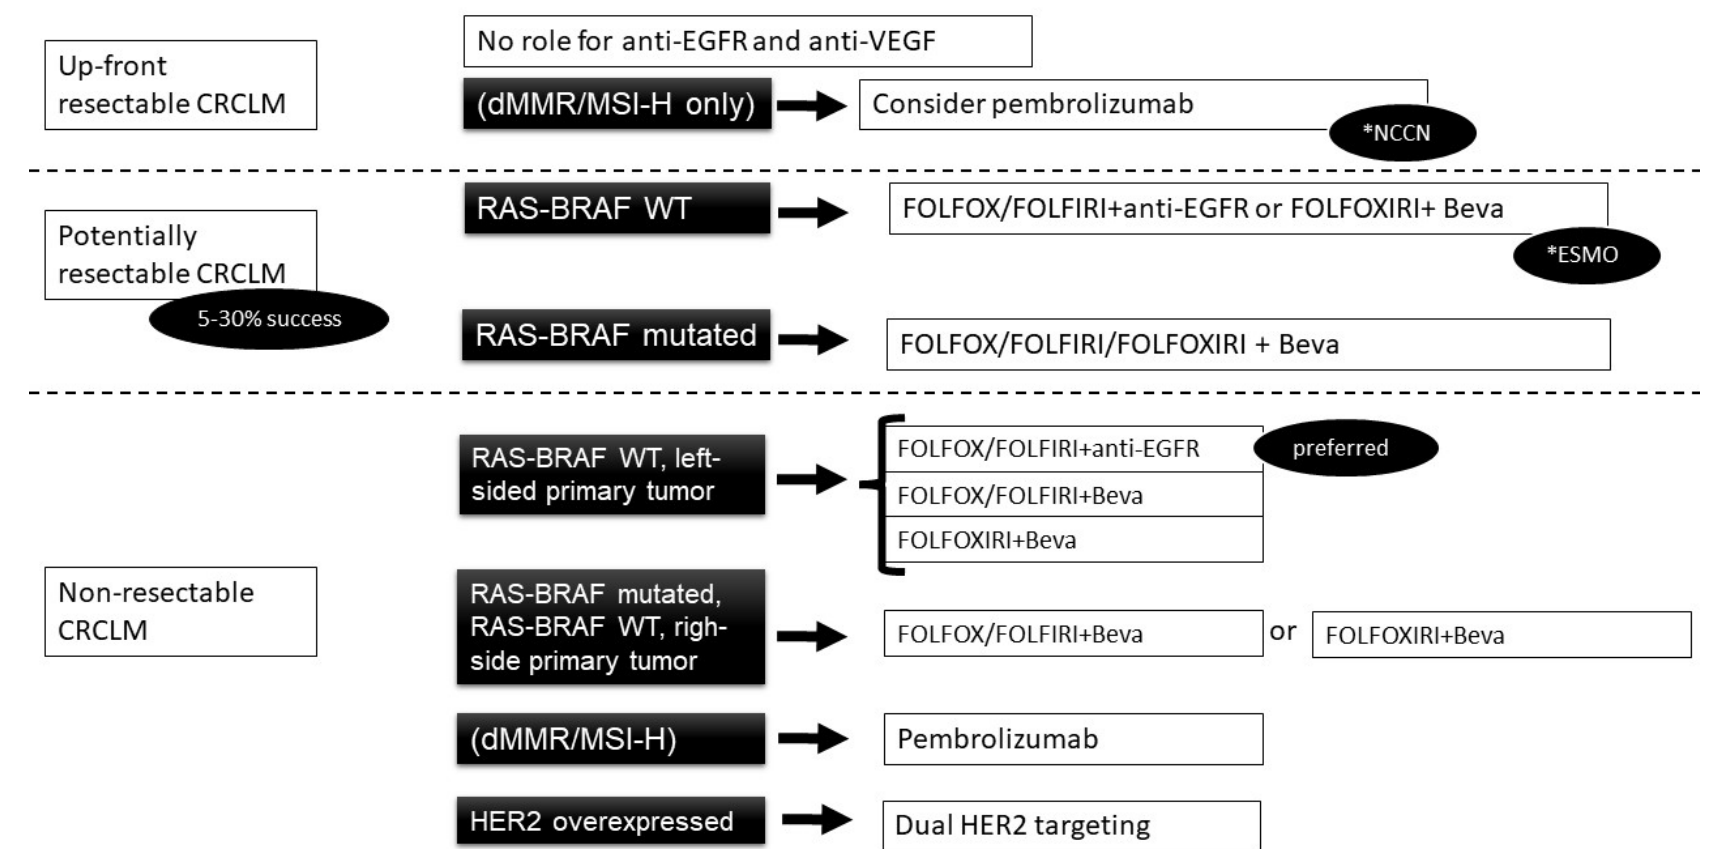
Figure 1. Algorithm of the role of molecular characteristics in the choice of treatment in CRCLM (*—as described in the specified guidelines)